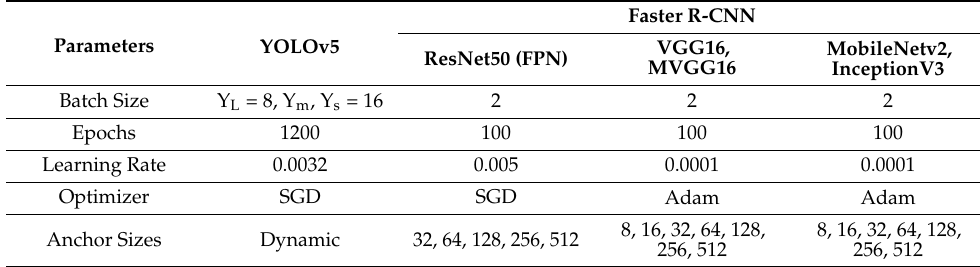
Figure 6. Data augmentations: ( a ) Mosaic YOLOv5, ( b ) Faster R-CNN.